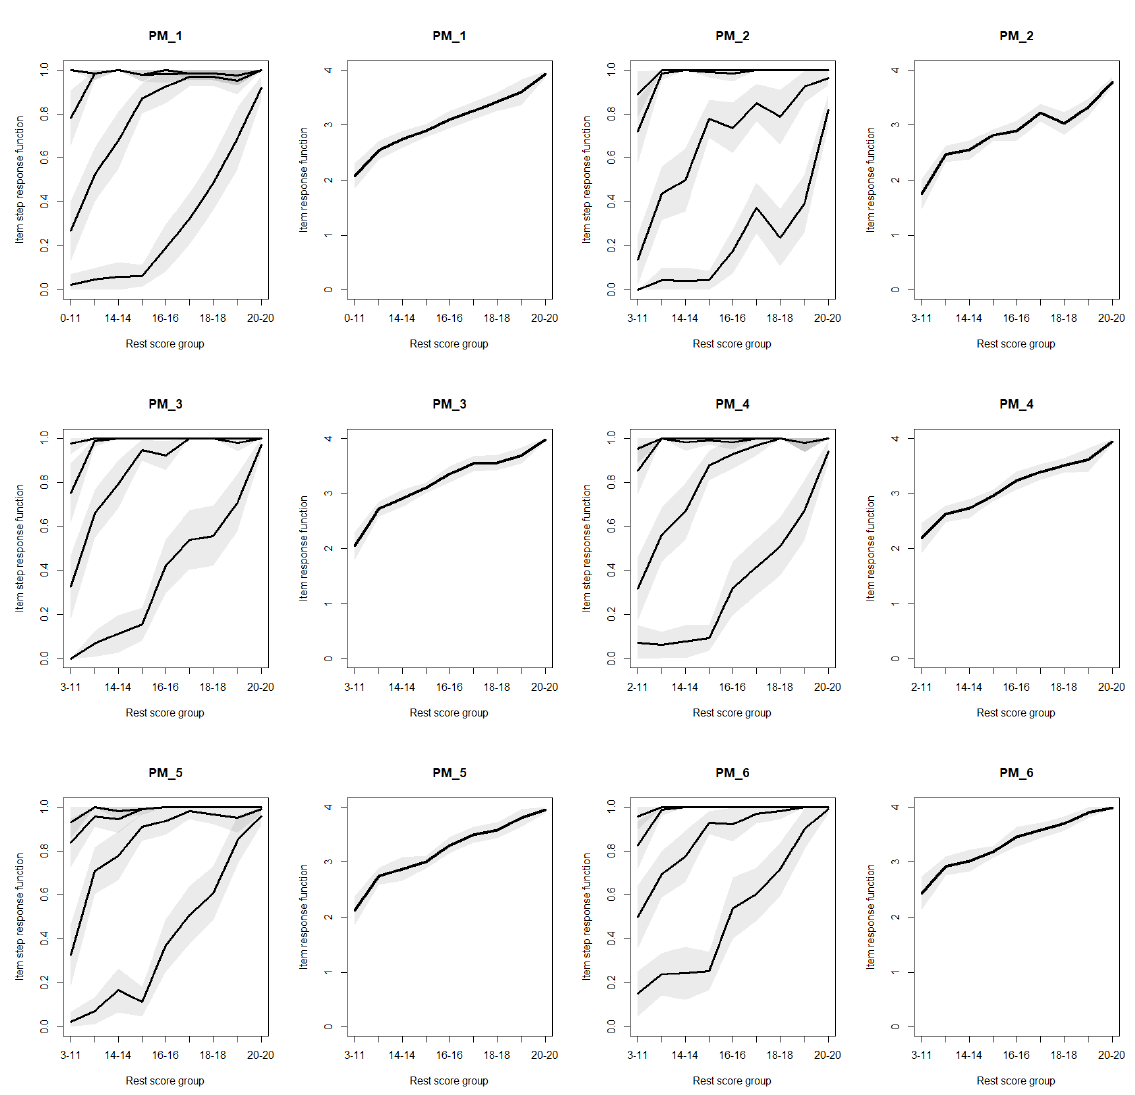
Figure 2. Monotonicity analysis of test items that comprise PIS. Each test item is accompanied by two illustrations — item step response function (on the left) and item response function (on the right).